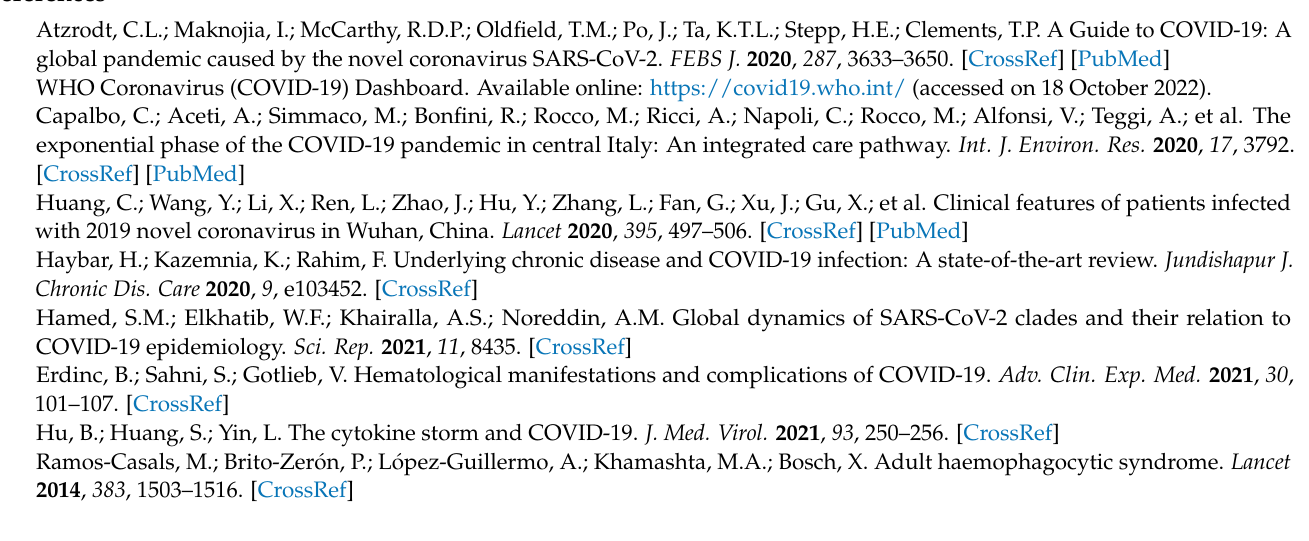
Table S2: Data of hospitalization and blood biochemistry of the individuals with severe and